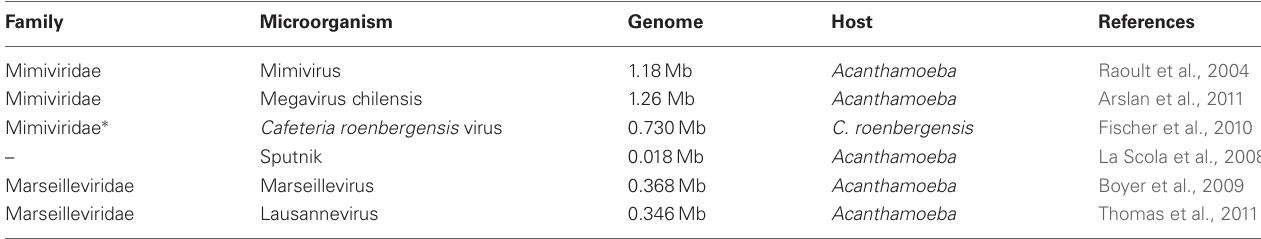
Table 1 | Amoeba-resisting viruses with a publicly available genome